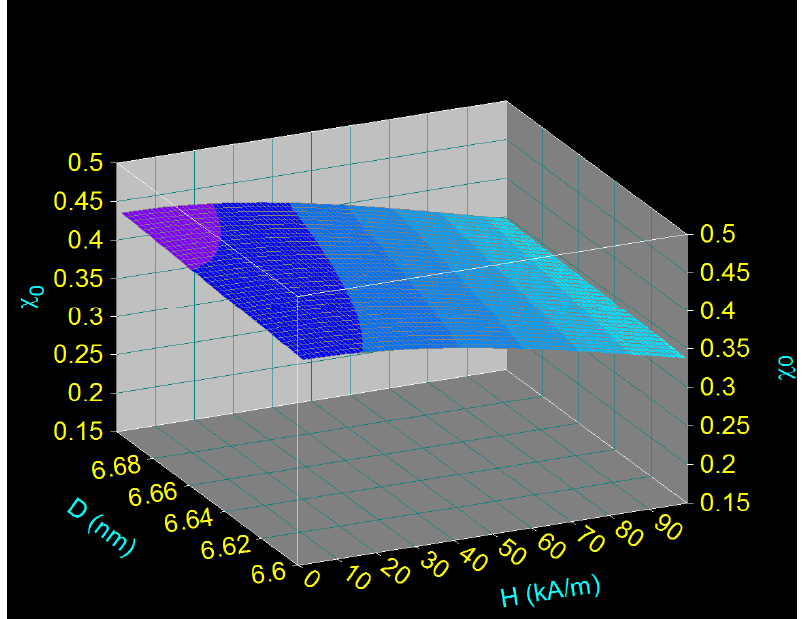
Figure 5. The variation of magnetic susceptibility of CoFe 2 O 4 nanoparticles as a function of the amplitude of magnetic field H up to 100 kA/m, for the diameters of nanoparticles of 6.6–6.7 nm.